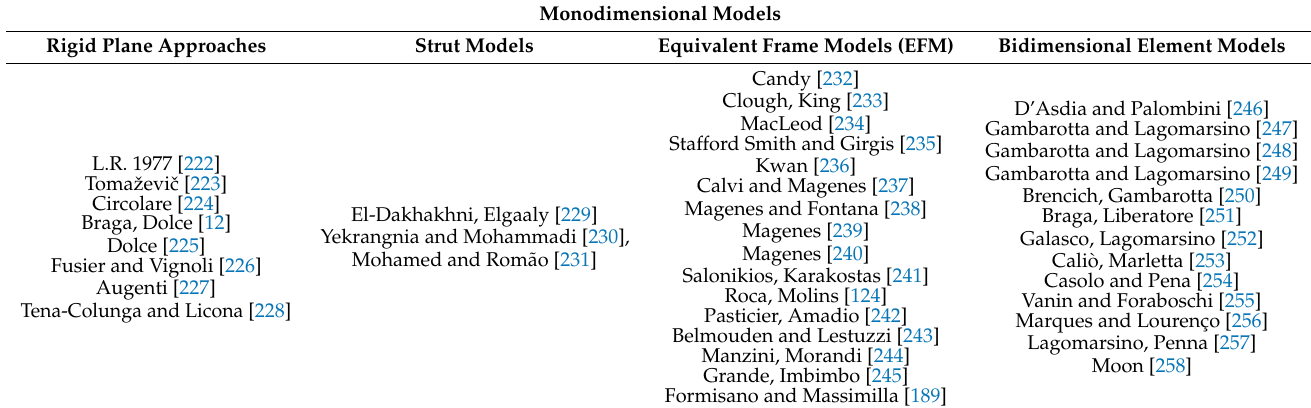
Table 4. Summary of different proposals for the monodimensional models of masonry